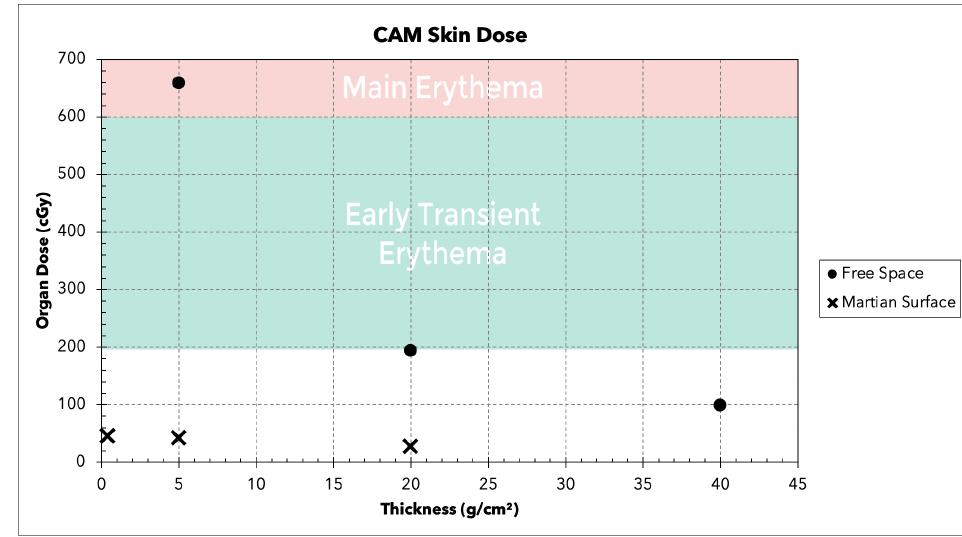
Figure 2. Skin doses from 993/4 SPE for CAM behind various thicknesses of aluminum shielding. The possible biological damage threshold regions are labeled in the